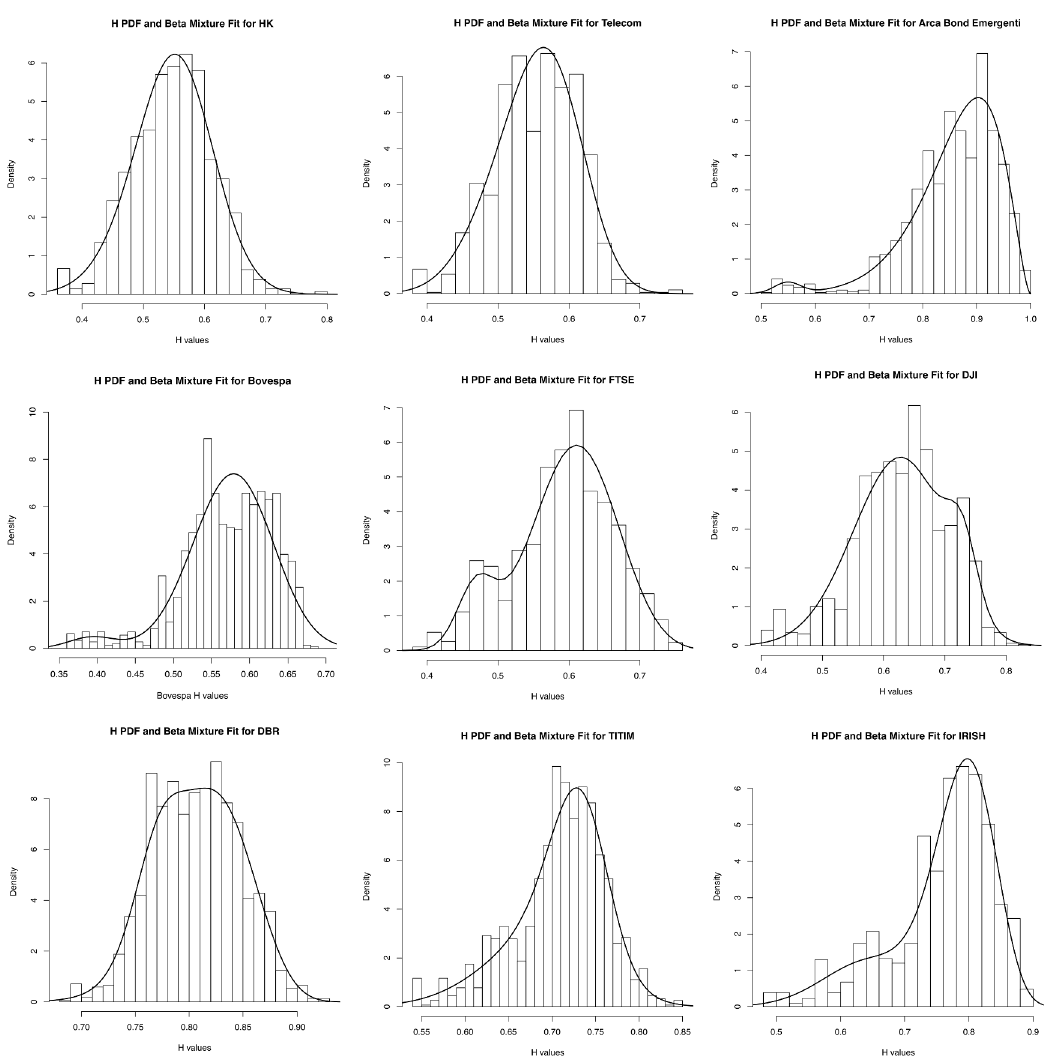
Fig 1. Mixture of beta distribution fit to the Hölder exponent of different types of assets. The Hölder exponents are represented by histograms whose number of bins is determined by the Freedman-Diaconis rule, the probability density functions of the mixtures of beta are the black curves.